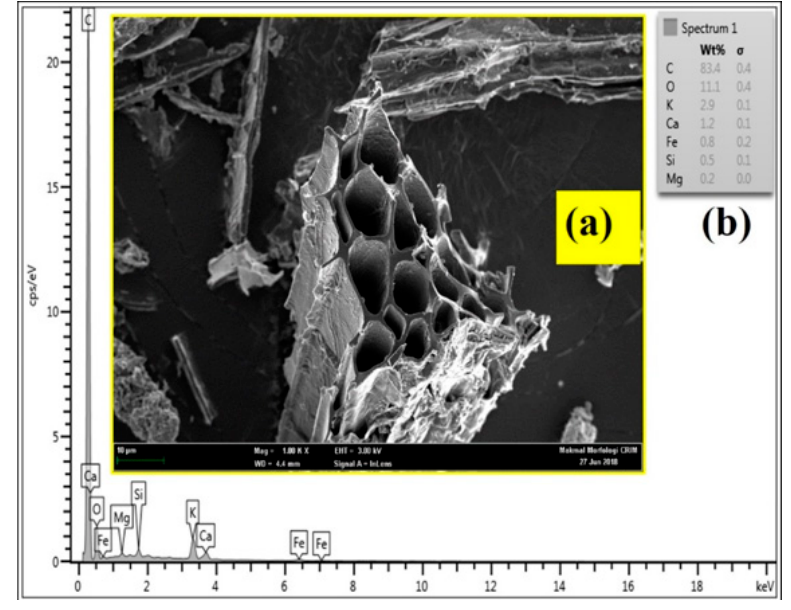
Figure 6. ( a ) FESEM image and ( b ) EDX profile of bio-powder activated carbon (bio-PAC).